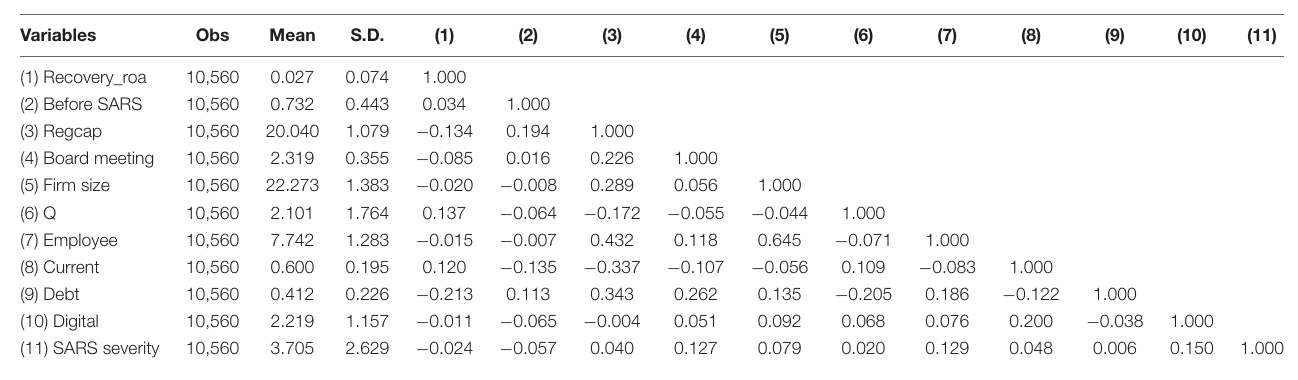
TABLE 2 | Descriptive statistics and